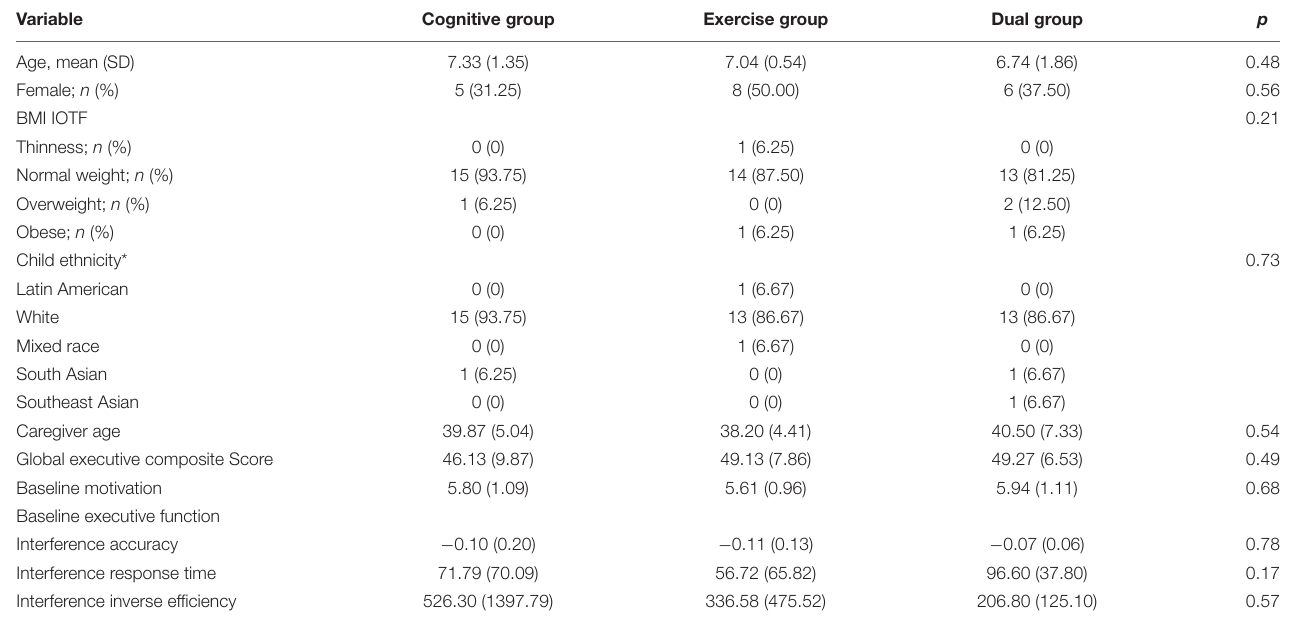
TABLE 1 | Demographic and baseline characteristics by